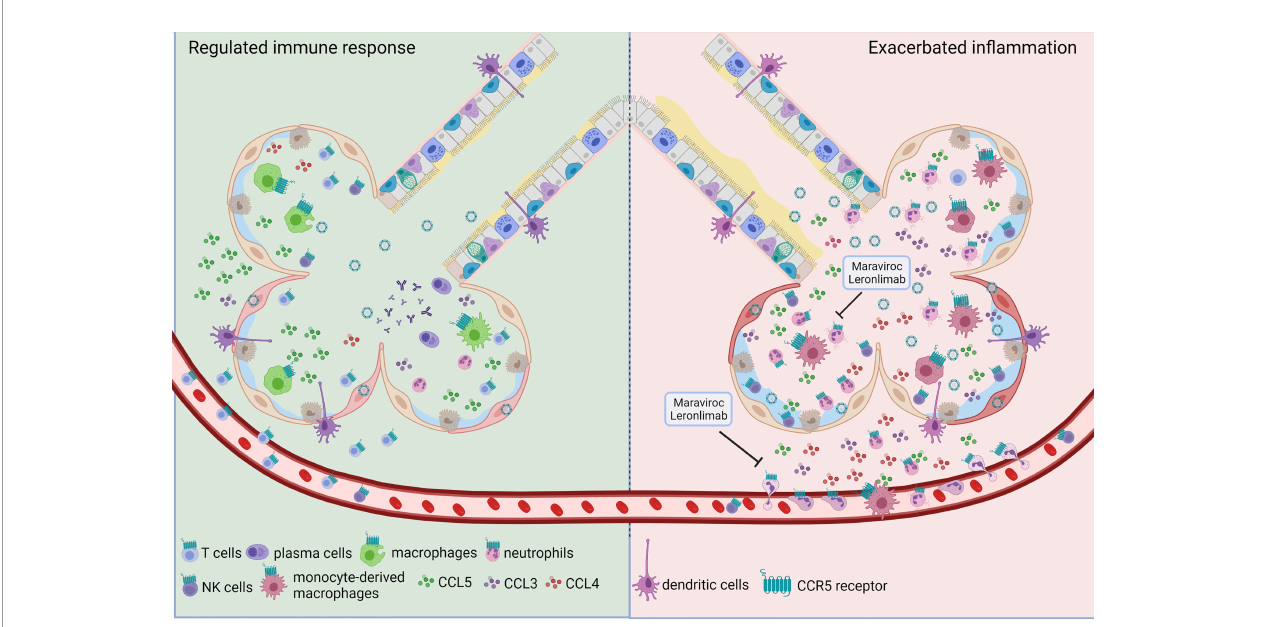
FIGURE 1 | The dual role of CCR5 during in fl uenza infection. Triggered by in fl uenza infection, one of the fi rst reactions of epithelial cells and resident alveolar macrophages is the production of CCR5 ligands. CCL5:CCR5 interaction is necessary for the development of a proper immune response (left side) to restrain viral expansion since it favors resident macrophages survival, promotes reprogramming of macrophages to pro-resolving phenotypes, mediates the recruitment of T lymphocytes and the establishment of iBALT contributing to immunological memory. However, uncontrolled activation of many components of the immune system after in fl uenza infection is associated with severe pulmonary damage (right side). In this scenario, increased recruitment of neutrophils, in fl ammatory monocytes and natural killer cells can be mediated by CCR5 expression on those cells, and the actual evidence shows that CCL3 may be related to this exacerbated response. In this situation CCR5 inhibition by Maraviroc or Leronlimab, might represent an interesting therapeutic